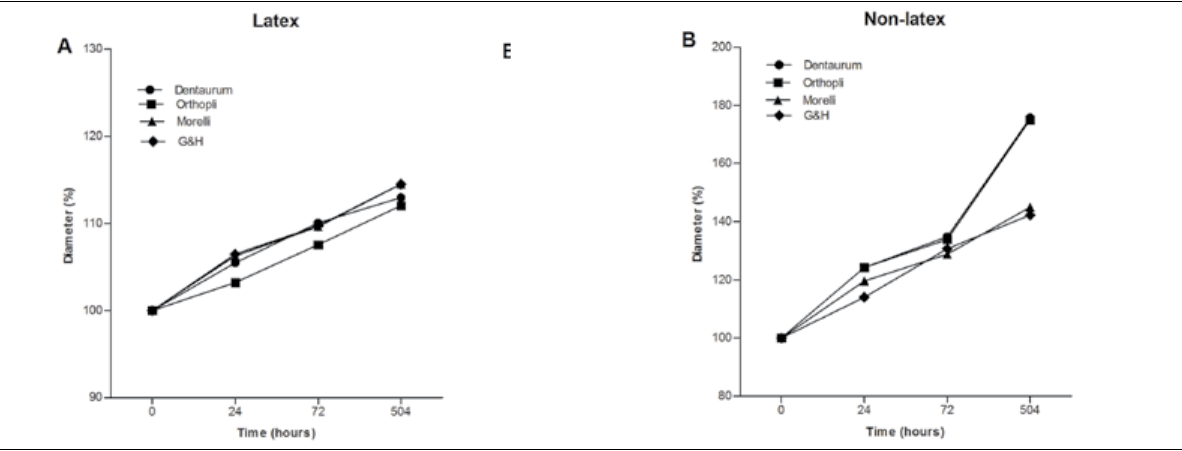
Figure 8. Comparison of the internal diameter deformation (%) of the latex (A) and the non-latex (B) elastics: Dentaurum, Orthopli, Morelli and G&H, in all experimental periods. p <